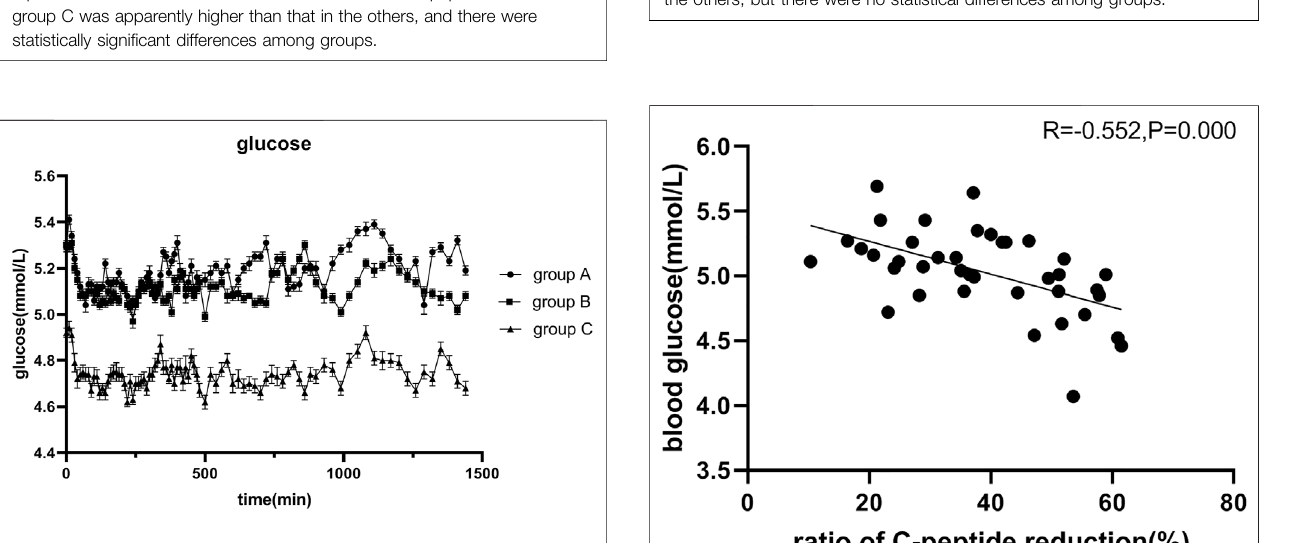
FIGURE 2 | Blood glucose versus time after 0.4 IU/kg doses of glargine insulin in healthy volunteers. The error bars represent the 95% con fi dence intervals. The blood glucose in group C was obviously lower than that in the others, and signi fi cances were found in three groups.